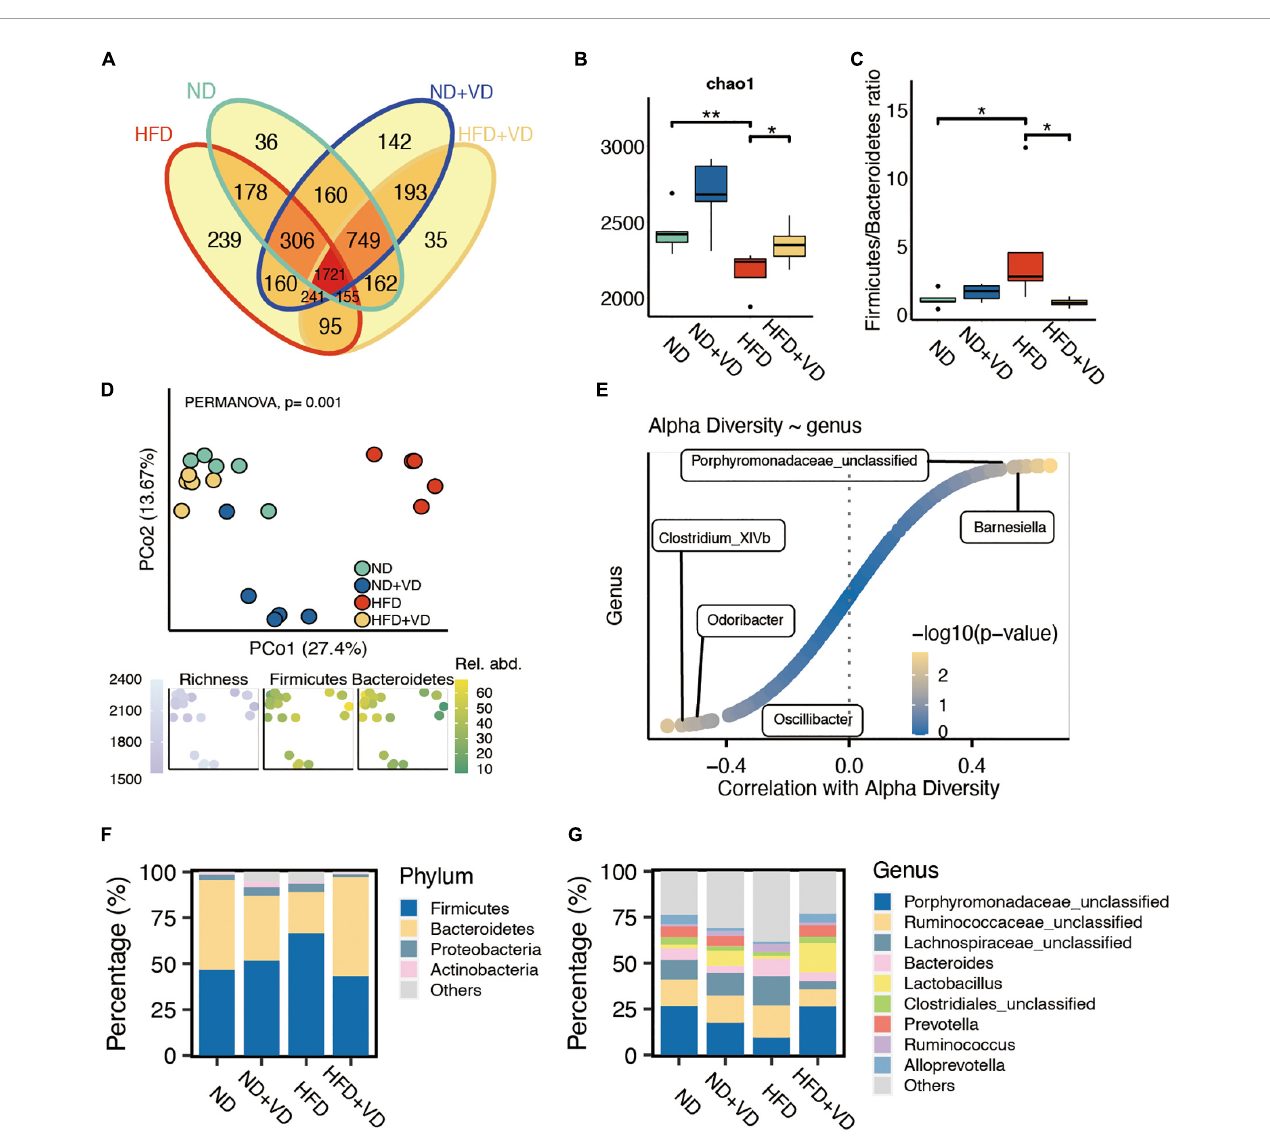
FIGURE2 Altered fecal microbiota after vitamin D (VD) treatment. (A) The shared and unique observed operational taxonomic units (OTUs) are in four groups. (B) The alpha diversity difference among groups. (C) The comparison of phylum Firmicutes/Bacteroidetes ratio in four group samples. (D) Principal coordinate analysis (PCoA) reveals a clear distinct difference in gut microbiota in four groups. (E) The correlation between alpha diversity and alerted gut microbiome. (F,G) Stacked bar plots depicting the percentage of phylum (left) and genus (right) of intestinal bacteria in the screening results. * P < 0.05, ** P < 0.01. Kruskal–Wallis test with post-hoc Dunn’s